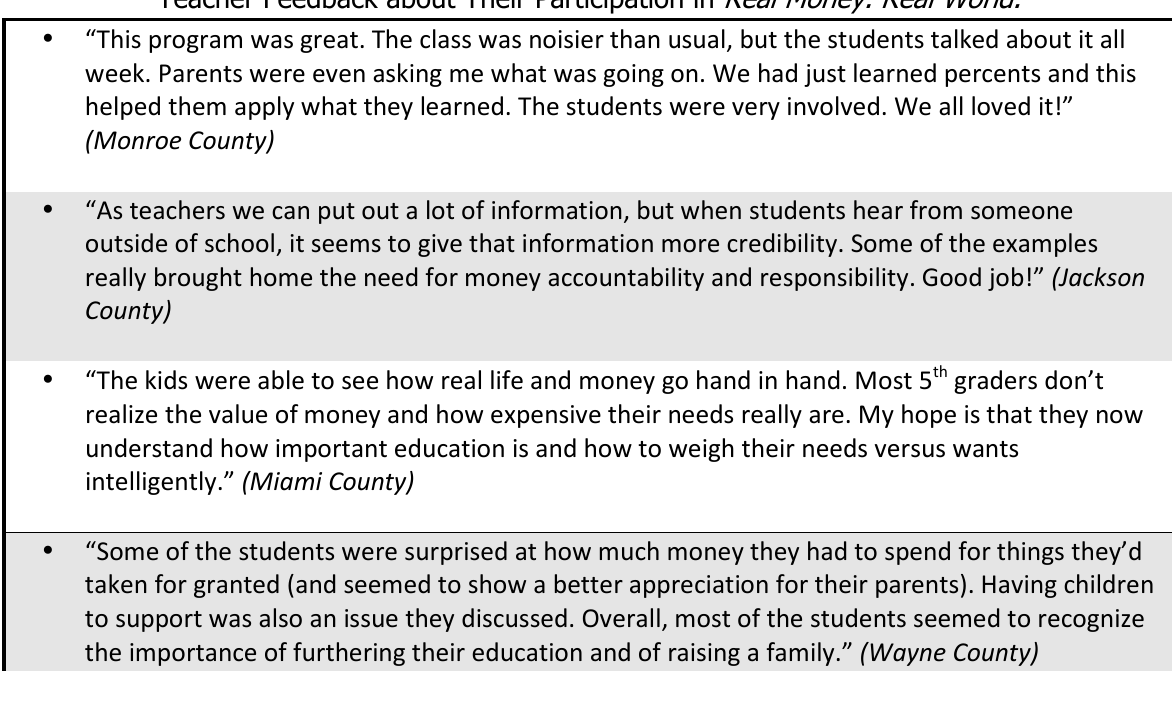
Teacher Feedback about Their Participation in Real Money. Real